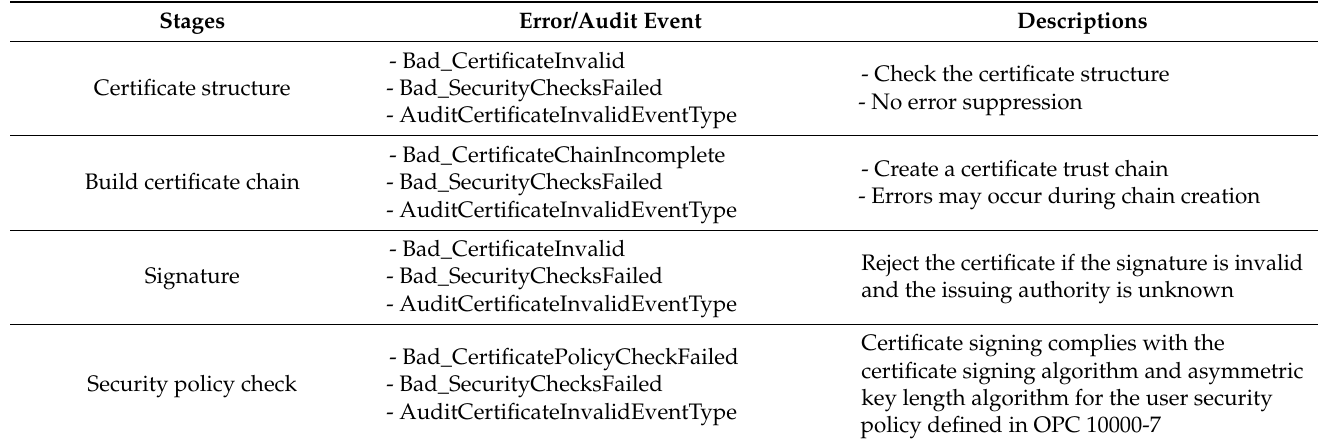
Table A2. Certificate management and deployment